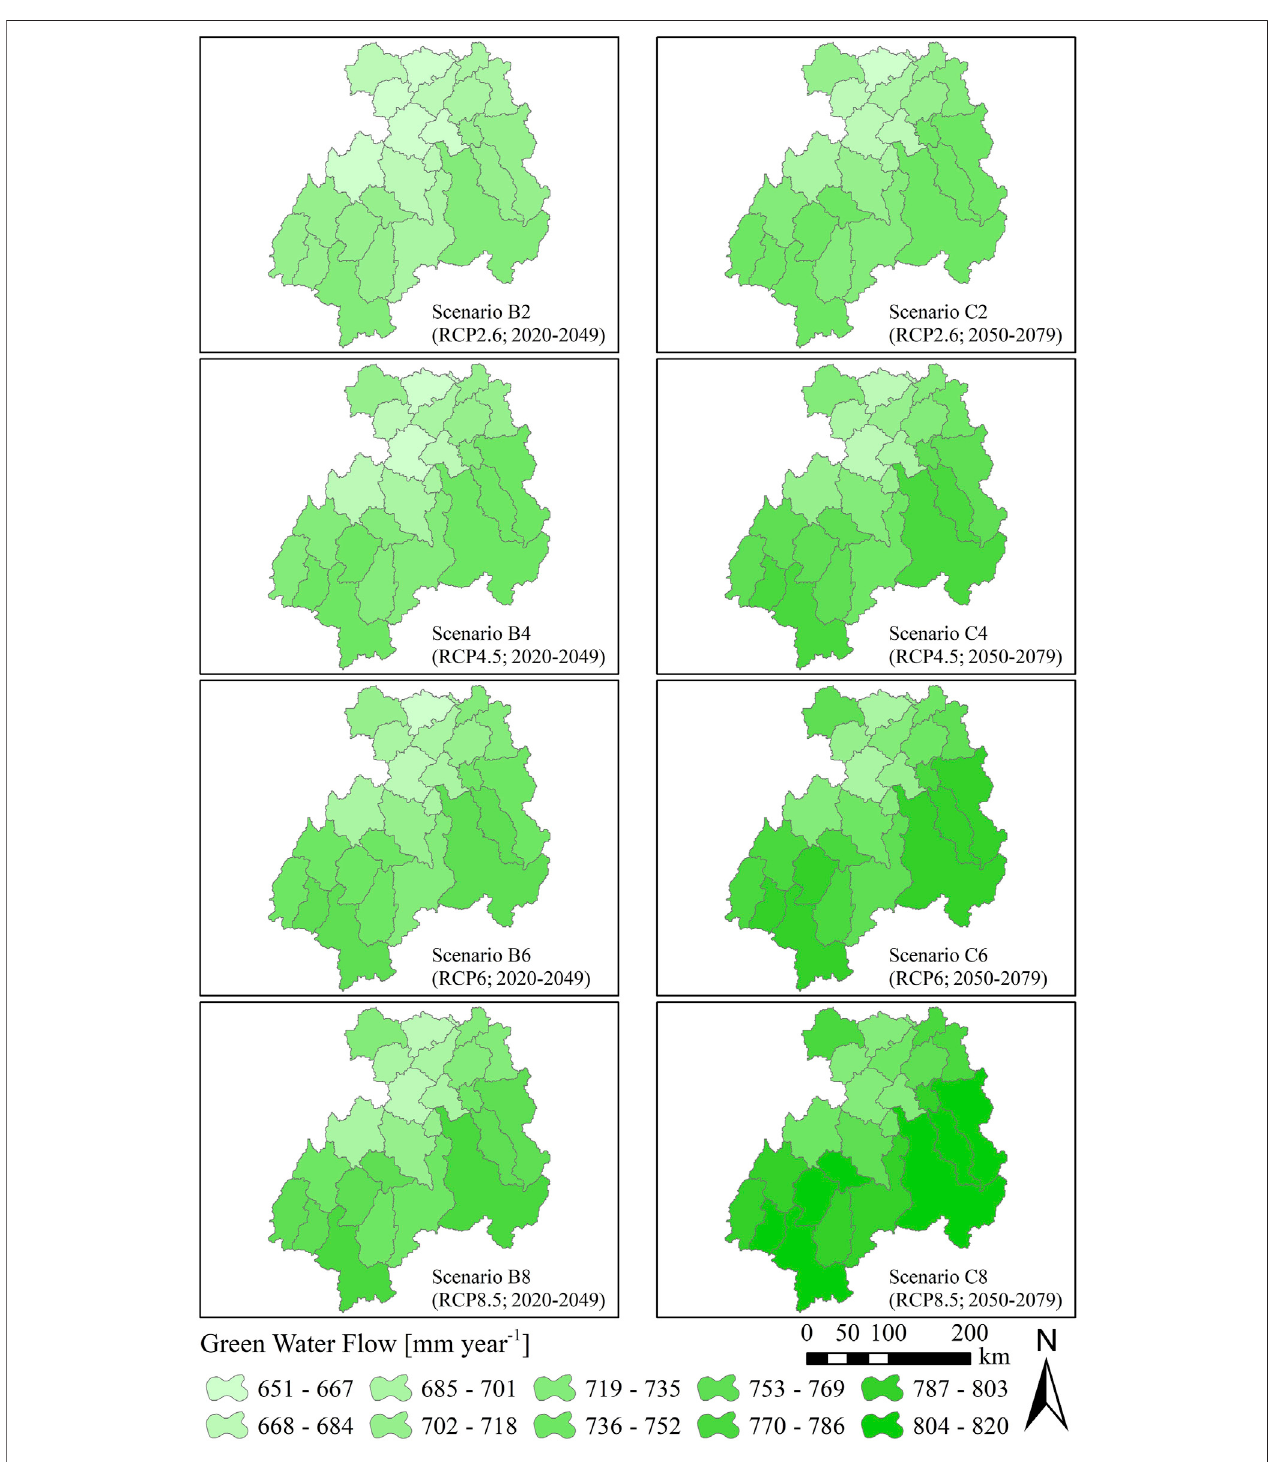
FIGURE 11 | Spatial distributions of the annual average green water fl ow (mm yr − 1 ) under different RCPs in future HadCM3 climate scenarios (2020 – 2079) in the Xiangjiang River Basin.